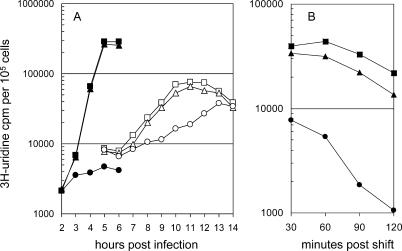
RNA Synthesis Phenotype of the Alb ts22 MutantRNA synthesis was determined (A) using 1 h pulse labels with 3H-uridine in the presence of dactinomycin, given to MHV-A59-, Alb ts22-, and Alb 22R-infected cells 1–6 hpi at 40 °C or 5–14 hpi at 30 °C; █, 40 °C, wt MHV-A59; ▴, 40 °C, Alb 22R; •, 40 °C, Alb ts22; □, 30 °C, wt MHV-A59; ▵, 30 °C, Alb 22R; ○, 30 °C, Alb ts22, or (B) using 30 min pulse labels with 3H-uridine in the presence of dactinomycin, given to MHV-A59-, Alb ts22-, and Alb 22R-infected cells after shift from the permissive to the non-permissive temperature at 13 hpi; █, wt MHV-A59; ▴, Alb 22R; •, Alb ts22.